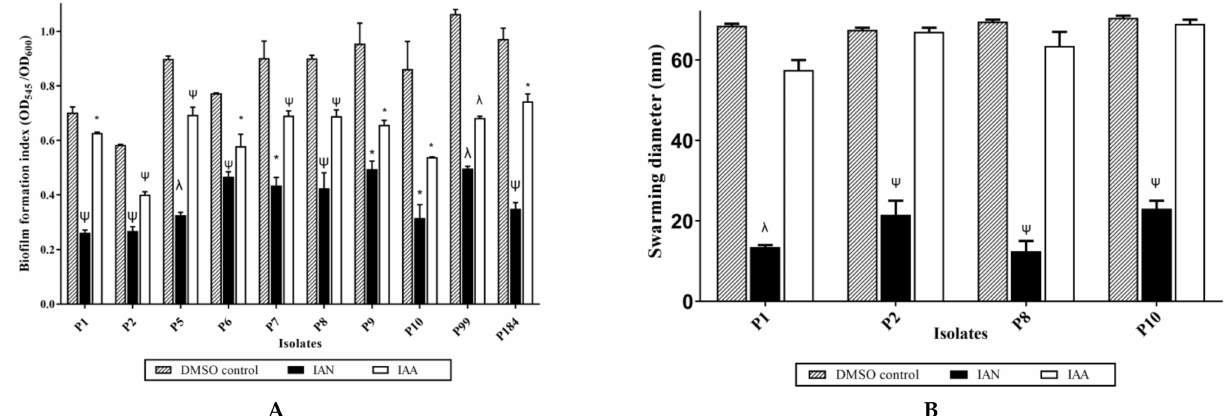
Figure 8. Effect of synthetic indole-3-acetonitrile (IAN) and indole-3-acetic acid (IAA) at concentration of 50 µ g/mL on the virulence phenotype of P. mirabilis ( A ) Biofilm formation index of ten P. mirabilis isolates, ( B ) Swarming motility of four P. mirabilis isolates, Data represents the mean of at least 3 replicates, and error bars show standard error of the mean and statistical difference was evaluated by student’s t -test * p < 0.05; ψ p < 0.01; λ p < 0.001 compared with DMSO